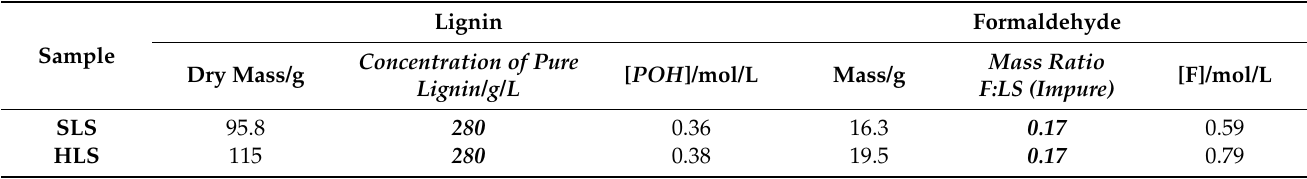
Table 4. Initial quantities of lignin and